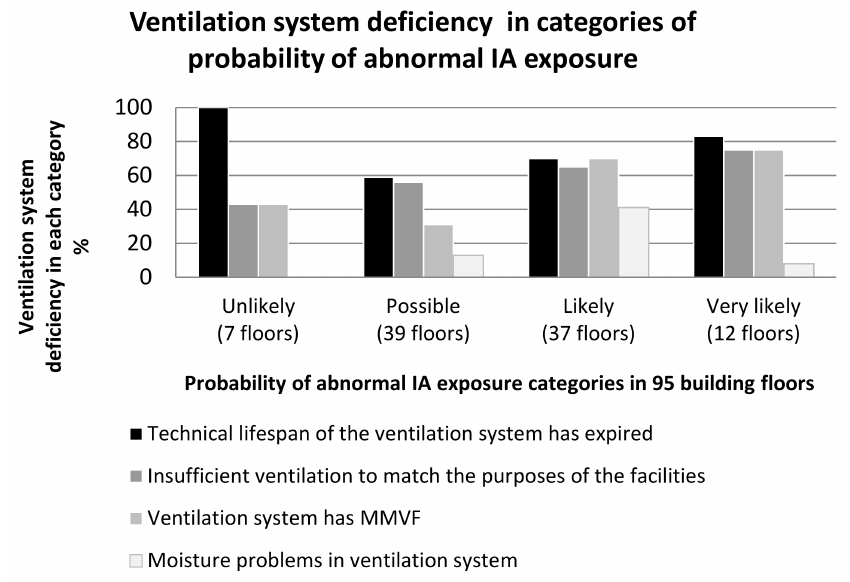
Figure 1. Categories of probability of abnormal indoor air (IA) exposure and ventilation system